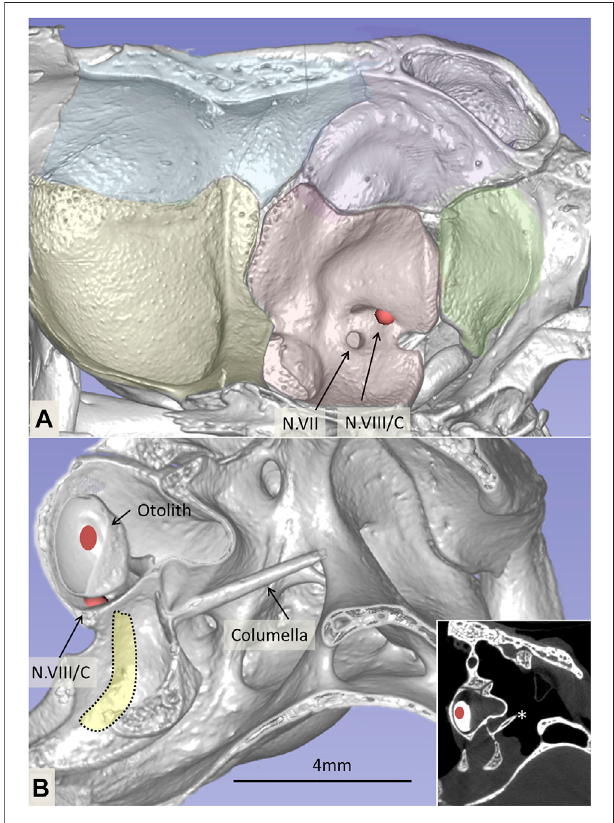
FIGURE 1 | (A) . Micro-CT and 3D reconstruction of the right cranial osteology of C. rhombifer (medial view). Foramina of the facial (N.VII) and vestibulocochlear cranial nerves (N.VIII) are outlined with arrows. The vestibular and cochlear nerves pass through different foramina. (B) . Cropped 3D reconstruction shows the otolith, ear bone columella (*), and the foramen of the cochlear nerve. The inset shows the corresponding coronal